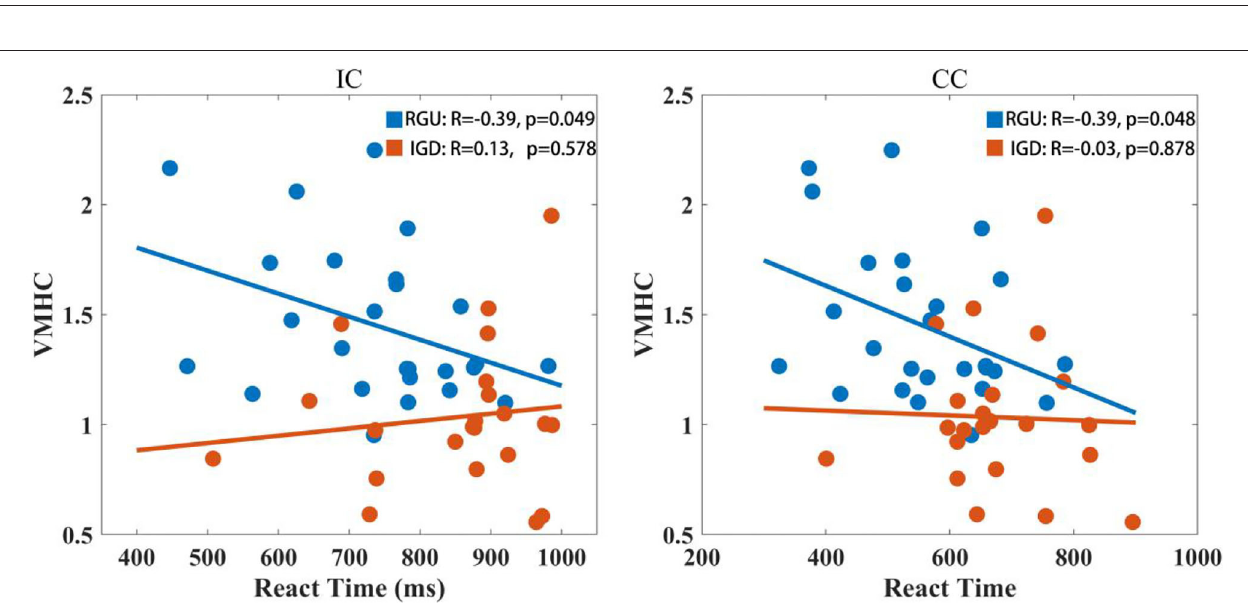
FIGURE 4 | Correlation analysis of VMHC value with RT. The left shows the correlation analysis between RT and VMHC values of the two groups in the IC condition. The right shows the correlation analysis between RT and VMHC values of the two groups in the CC condition.